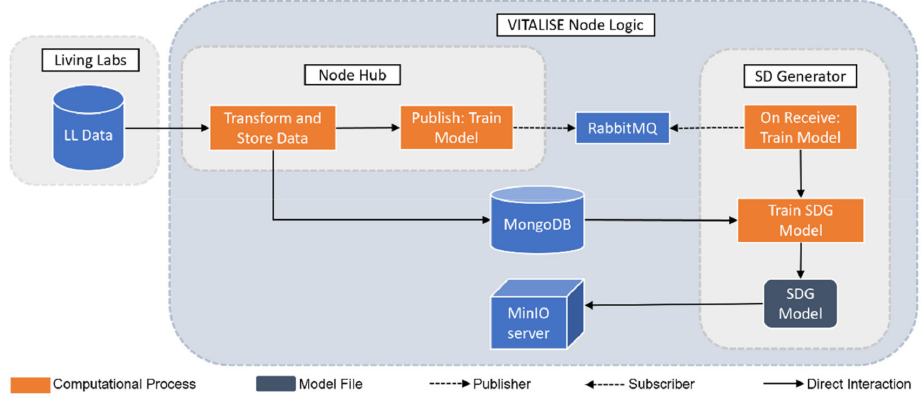
Figure 3. SDG model training